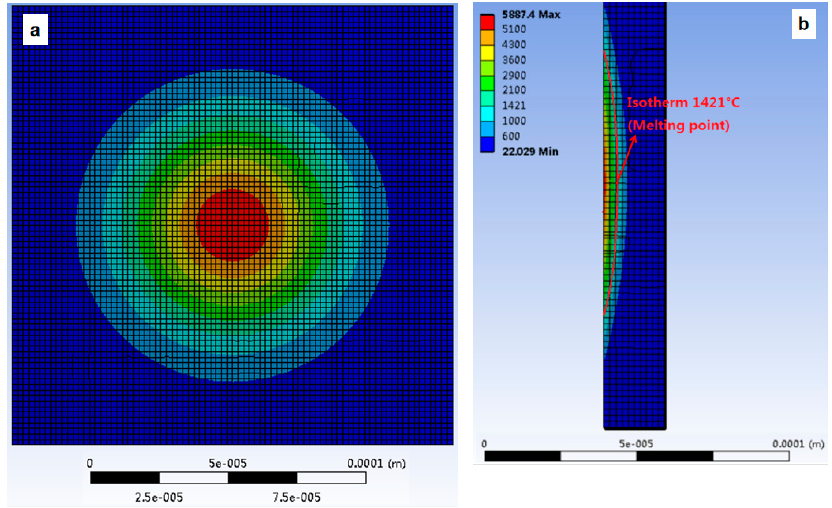
Figure 7. Numerical simulation of crater volume. Single discharge on a flat surface: ( a ) Front view ( b ) lateral view.